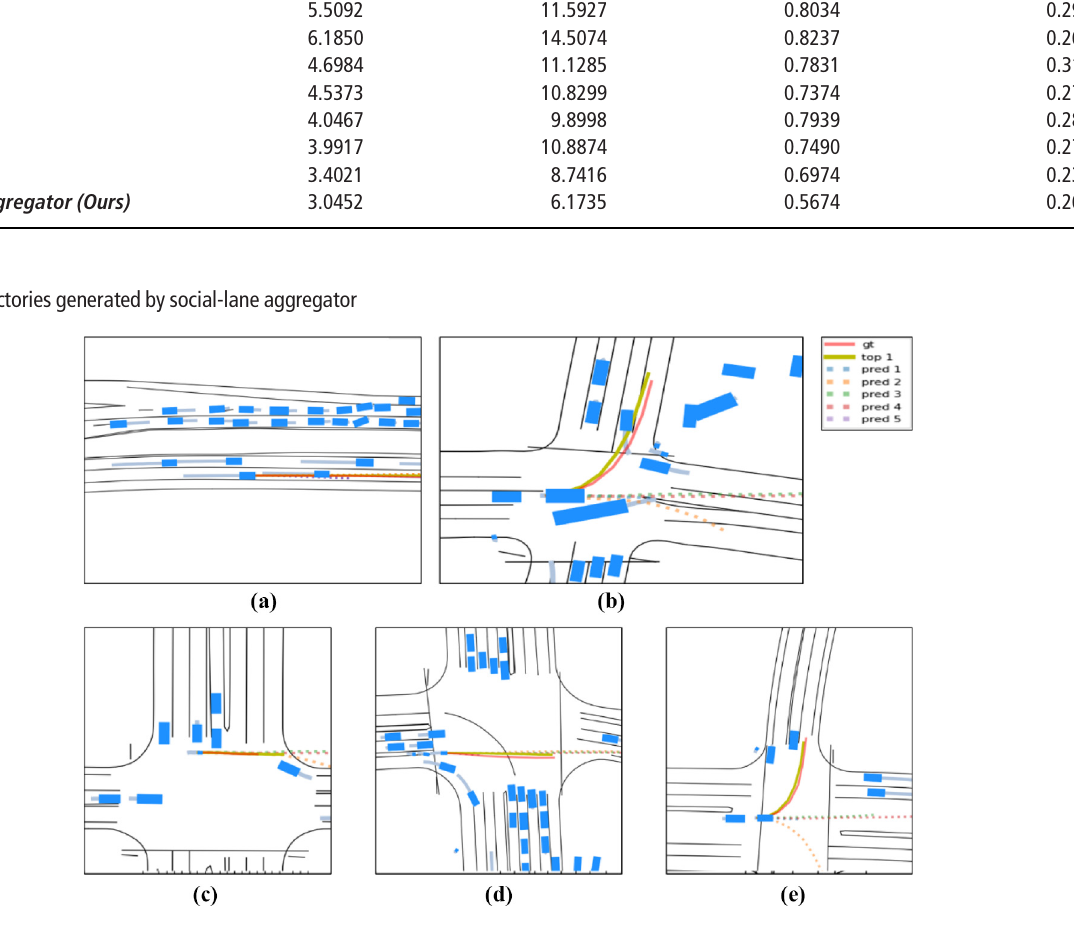
Table 1 Model performance on the Waymo Open Dataset Methods